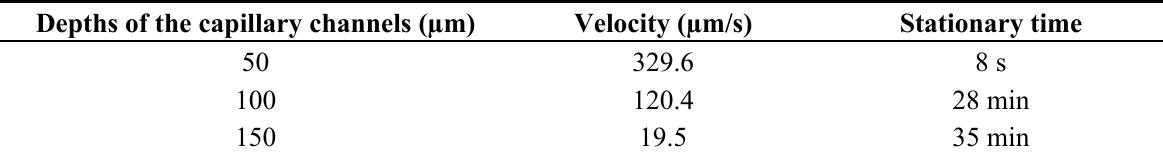
Table 5. The fluid stationary time is for the stop valves with the same 170° expansion angle and the same width of 100 µm but the valve having three different aspect ratios of the patterns. The PEO-PDMS cover is in the 0.4% PEO